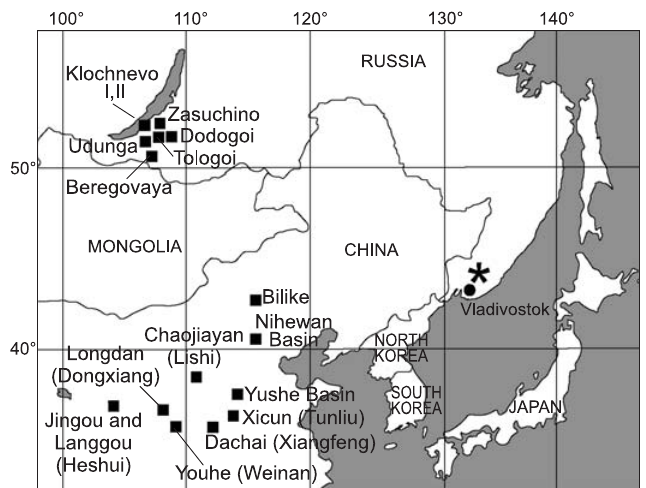
Fig. 1. Localities of fossil Mimomys in Transbaikalia, Primorye, and China. Asterisk indicates the location of the Medvezhyi Klyk Cave.